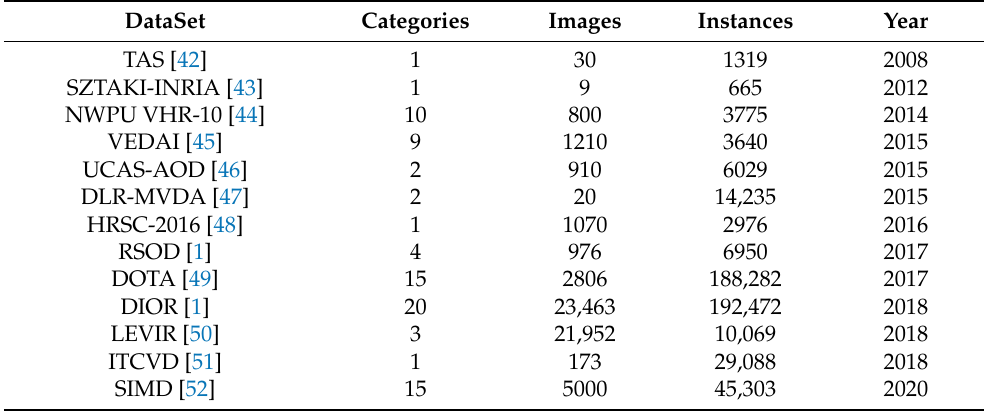
Table 1. Universal remote sensing image object detection